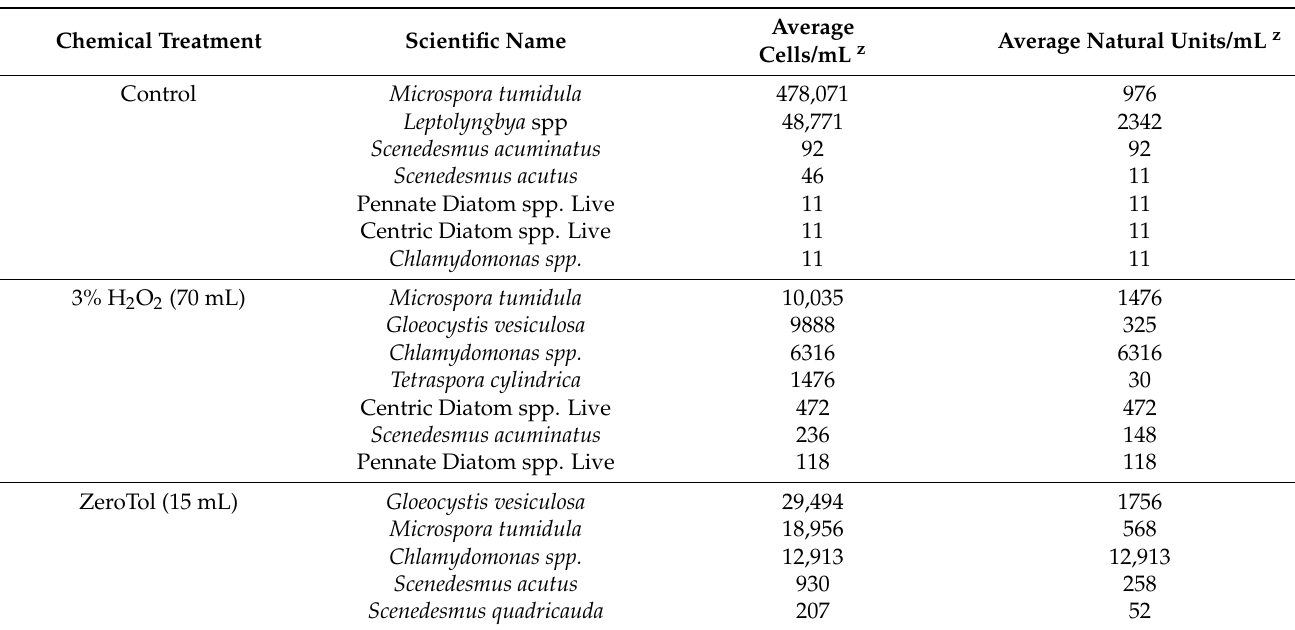
z Visual scale: 1 = little to no algae, 2 = some algae collected on sides and bottom, 3 = thick algae matt. y Means (n = 10) within a column followed by the same lowercase letter are not significantly different by pairwise comparison in the mixed model ( p ≤ 0.05). Table 9. Effects of different rates of three hydrogen peroxide products on taxonomic counts of algae present in ebb and flow hydroponic systems 30 days after production of lettuce and basil in OSU research greenhouses, Stillwater, OK for experiment